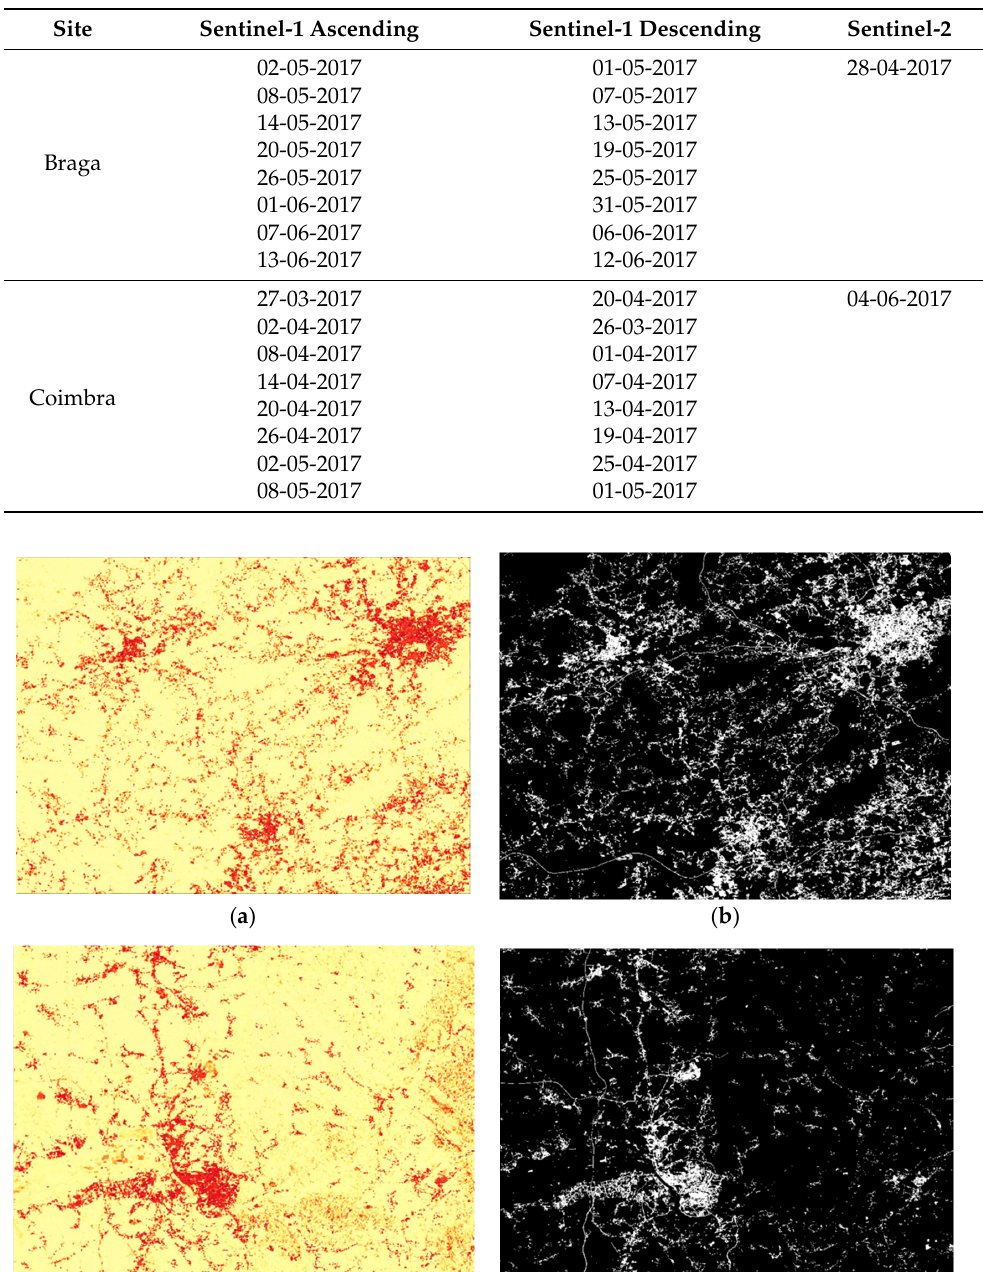
Table 2. Remote sensing data used for Portugal test sites.